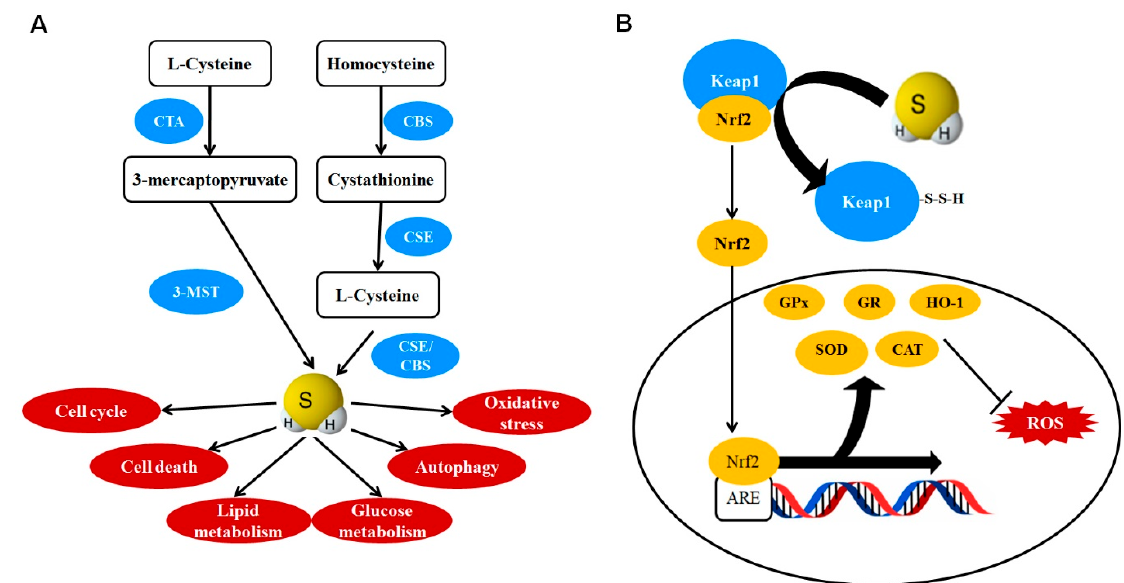
Figure 2. H 2 S is recognized as a novel gasotransmitter. ( A ) Enzymatic H 2 S production mediated by CSE, CBS, and 3MST/CAT. Endogenously produced H 2 S regulates diverse cellular functions, including cell cycle, cell death, lipid metabolism, glucose metabolism, oxidative stress, and autophagy. ( B ) H 2 S mediates its antioxidant effects through activation of Keap1/Nrf2. S-sulfhydration of cysteine residues on Keap1 causes the release of Nrf2, which is then able to translocate into the nucleus and bind with ARE. Transcription of ARE leads to production of several AOEs, which collectively reduce oxidative stress. Abbreviations: 3-MST, 3-mercaptopyruvate sulfurtransferase; ARE, antioxidant response element; AOE, antioxidant enzyme; CAT, catalase; CBS, cystathionine β -synthase; CSE, cystathionine γ -lyase; CTA, cysteine transaminase; GPx, glutathione peroxidase; GR, glutathione reductase; H 2 S, hydrogen sulfide; Keap1, Kelch-like ECH associated protein 1; Nrf2, nuclear factor erythroid 2-related factor 2; SOD, superoxide dismutase; ROS, reactive oxygen species.